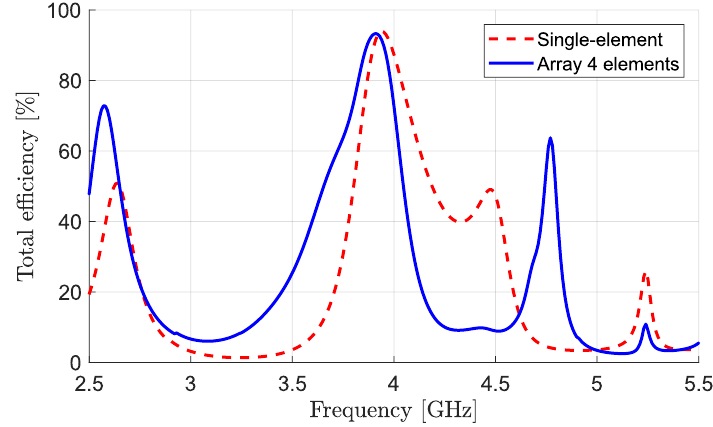
Figure 9. Efficiency of proposed DRA